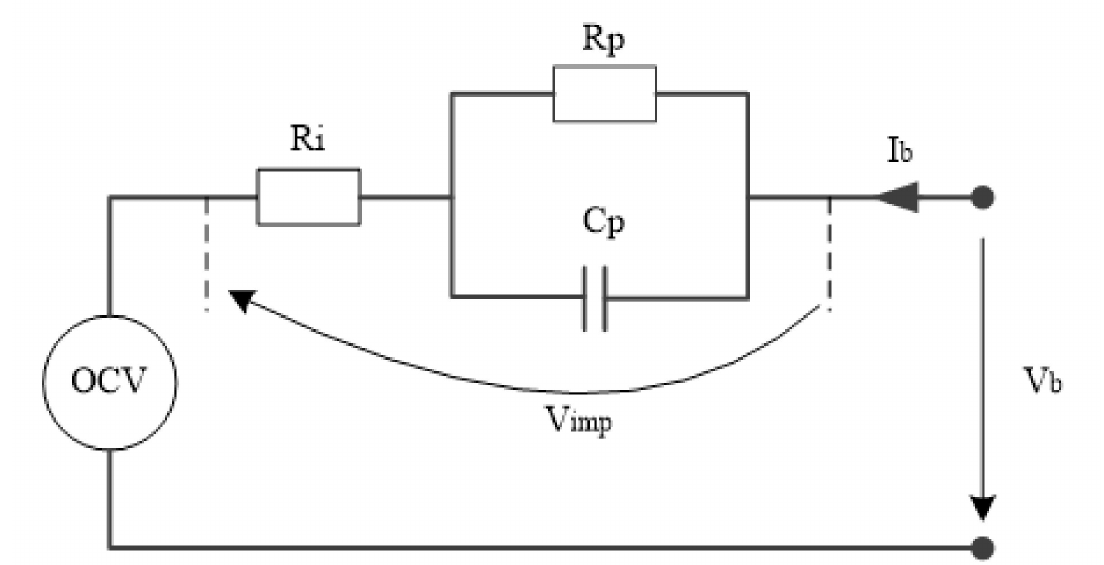
Figure 5. Equivalent circuit model of LiFePO 4